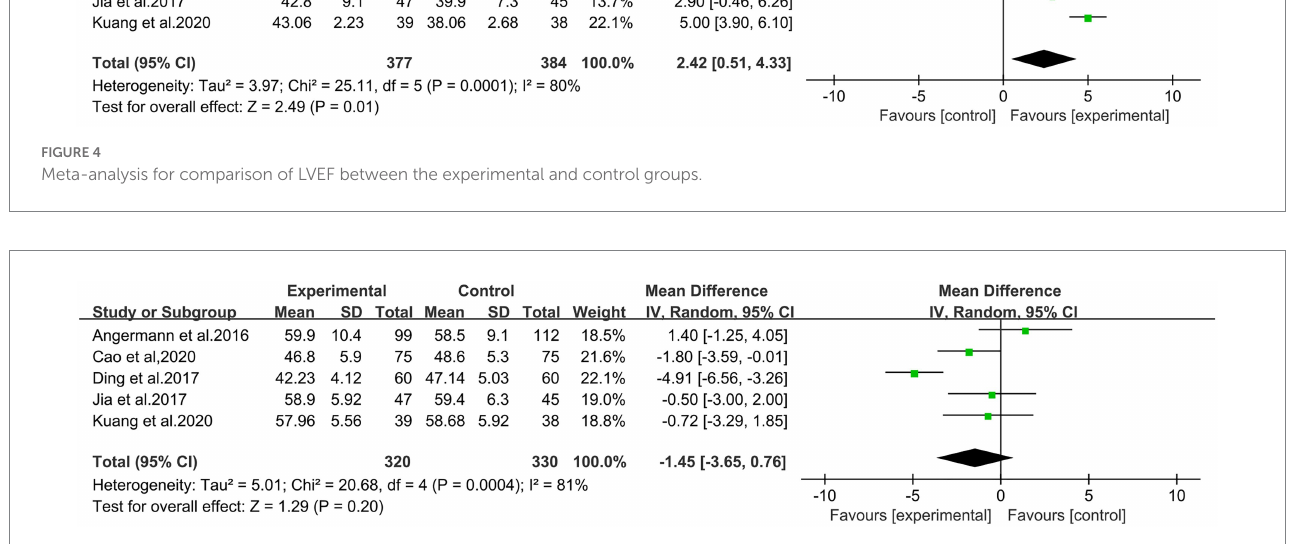
FIGURE 5 Meta-analysis for comparison of LVEDD between the experimental and control